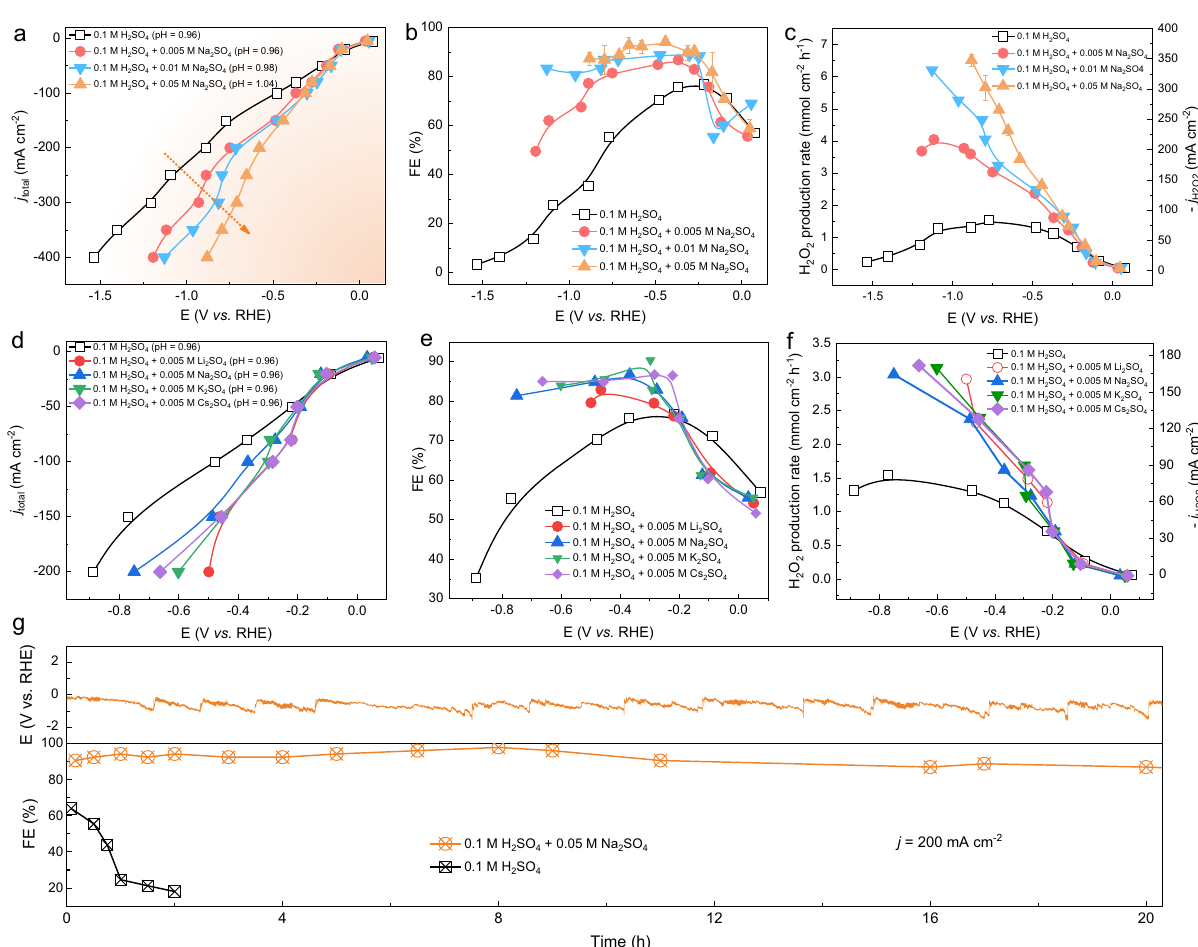
Fig. 3 The effect of alkali metal cation concentration and species on electrosynthesis of H 2 O 2 through 2e − – ORR. a The I-V curve of ORR with different concentrations of cations (from 0 to 0.05M Na 2 SO 4 ) in a fl ow cell. b The corresponding FEs and ( c ) production rates and partial current of H 2 O 2 products under different cell voltages. With the increase of cation concentration, the H 2 O 2 FE and production rate continuously increase at high current densities. The error bars represent two independent tests. d The I-V curve of ORR in 0.1M H 2 SO 4 containing different types of cations (0.005M X 2 SO 4 , X = Li + , Na + , K + , Cs + ) in a fl ow electrolyte cell. e Thecorresponding FEs and ( f ) production rates and partial current of H 2 O 2 products under different cell voltages. g Chronopotentiometry stability comparison of carbon catalysts BP2000 with/without cations by holding 200mA·cm − 2 current density for 20h in a fl ow cell for continuous electrolysis. The geometric area of the fl ow fi eld at the cathode in the fl ow cell is 1cm 2